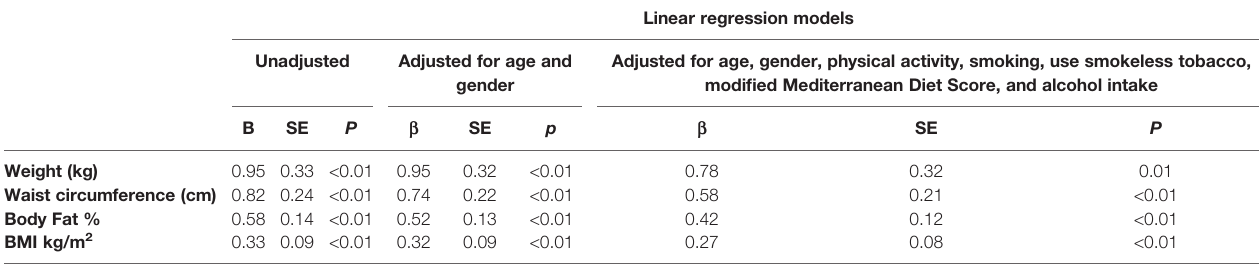
TABLE 5 | Effect of a unitary increase in the sleep quality index (SQI) on anthropometric variables.